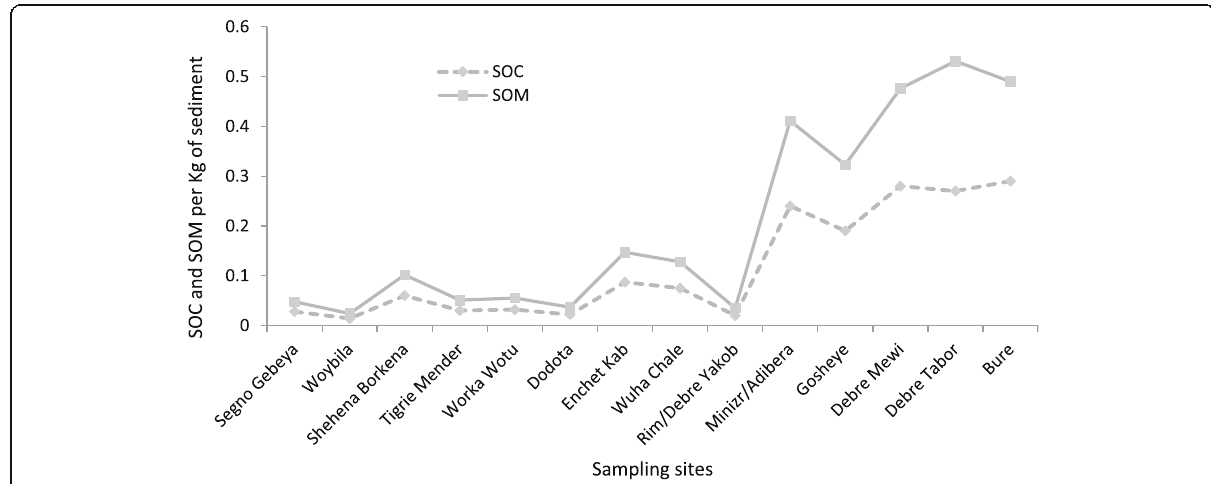
Fig. 3 Amount of SOC and SOM contained in a kilogram of sediment collected from fourteen locations